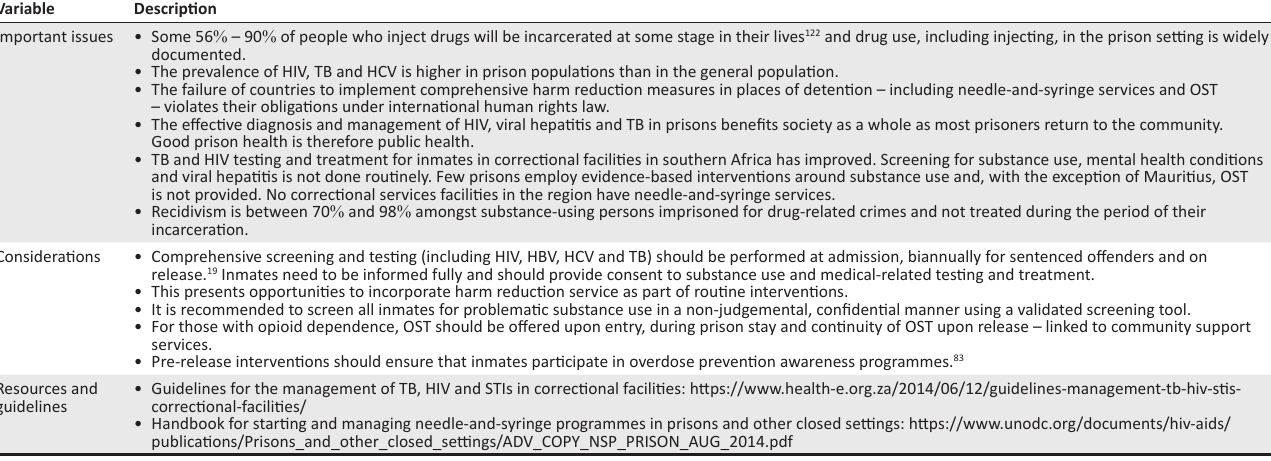
TABLE 28: Prison settings. Variable Description